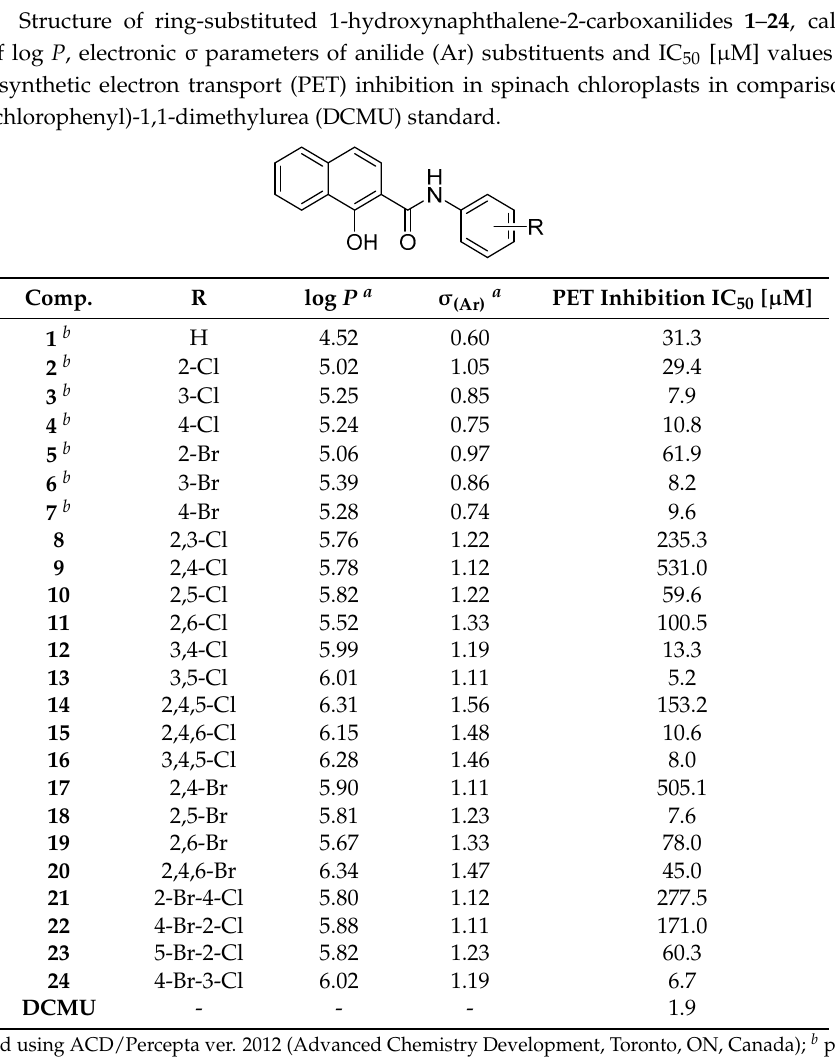
Table 1. Structure of ring-substituted 1-hydroxynaphthalene-2-carboxanilides 1 – 24 , calculated values of log P , electronic σ parameters of anilide (Ar) substituents and IC 50 [µM] values related to photosynthetic electron transport (PET) inhibition in spinach chloroplasts in comparison with